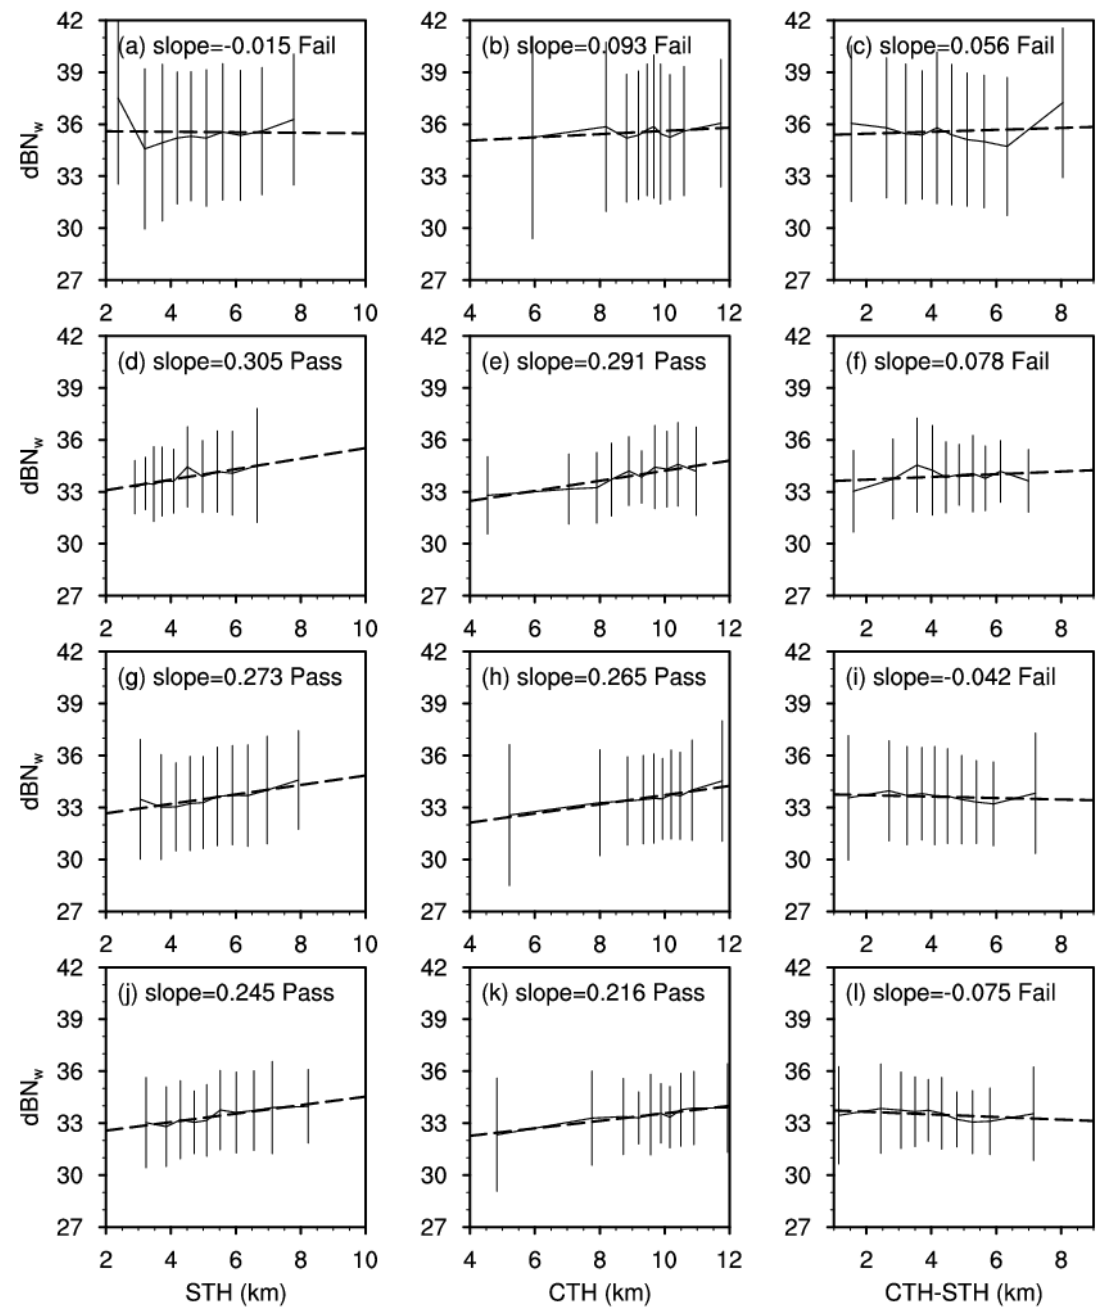
Figure 10. Relationship of STH (left), CTH (middle), and CTH-STH (right) with dBN w during the 2020-TC period. According to the classification shown in Figure 8, the different dominant physical processes under the melting level are represented from top to bottom: ( a – c ) coalescence, ( d – f ) size- sorting or evaporation, ( g – i ) break-up, and ( j – l ) break-up and coalescence balance. Bars represent the standard deviation; the dashed line is the line of best fit for 10 equal-sample points; the panel lettering of each sub-figure is followed by the slope of the line of best fit and whether it passes the 95% significance test.